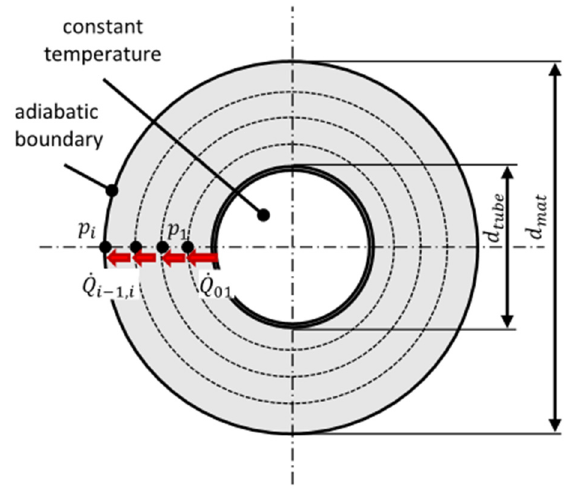
Figure 5. Schematic of the node model for LHTS and concrete storage. In this model, the storage material layer is divided to discrete volumes with index i